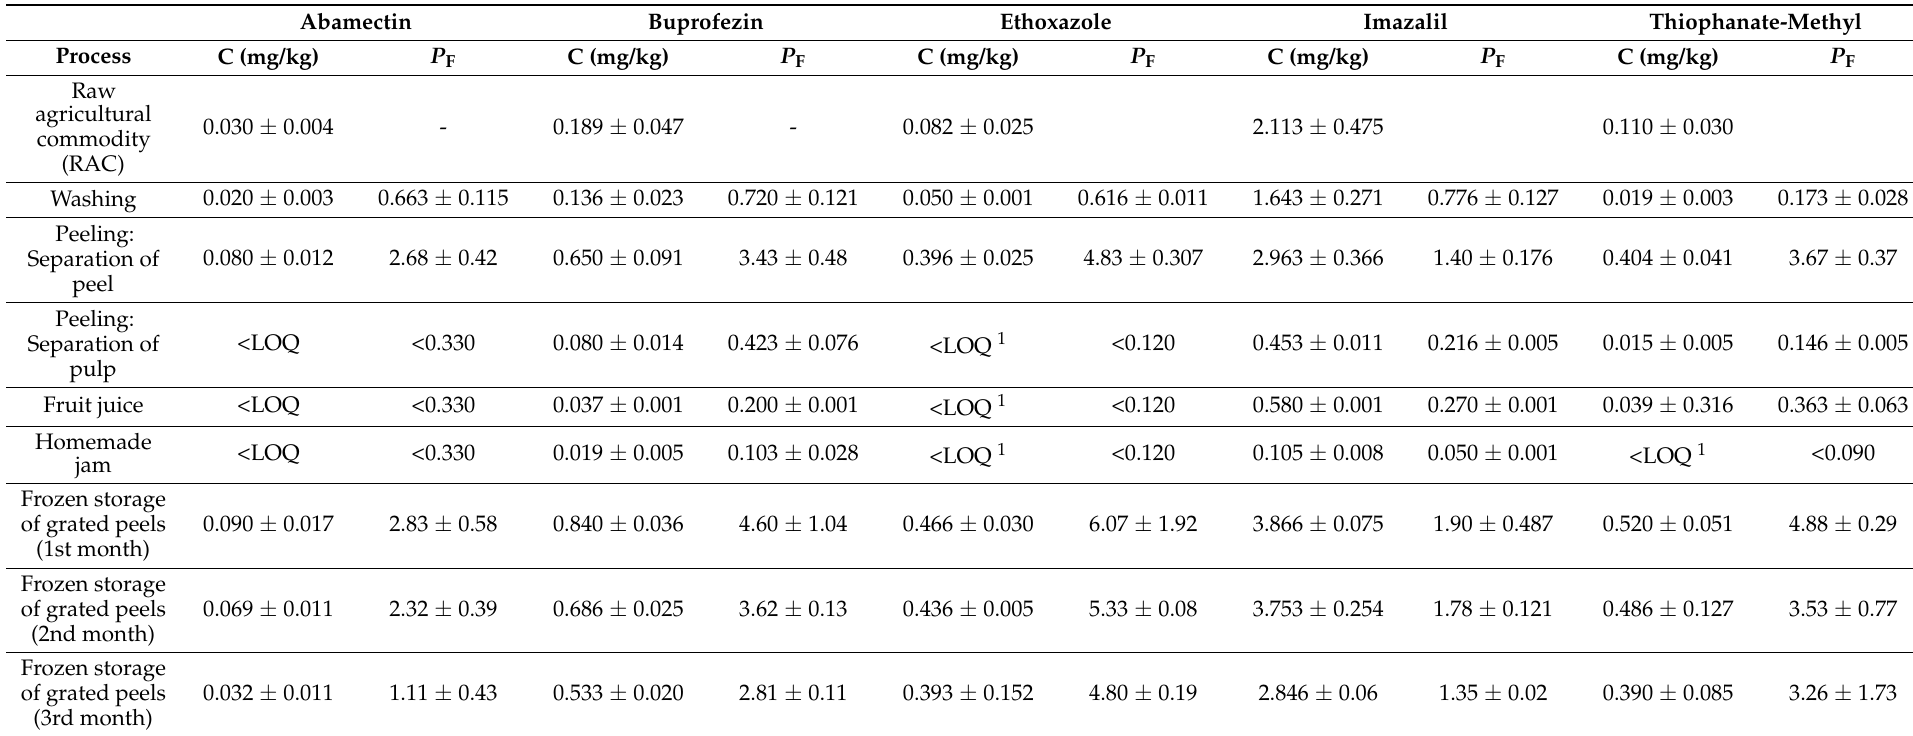
Table 1. Effect of household processing of orange on the concentration of pesticide residue and processing factors ( n = 3). Abamectin Buprofezin Ethoxazole Imazalil